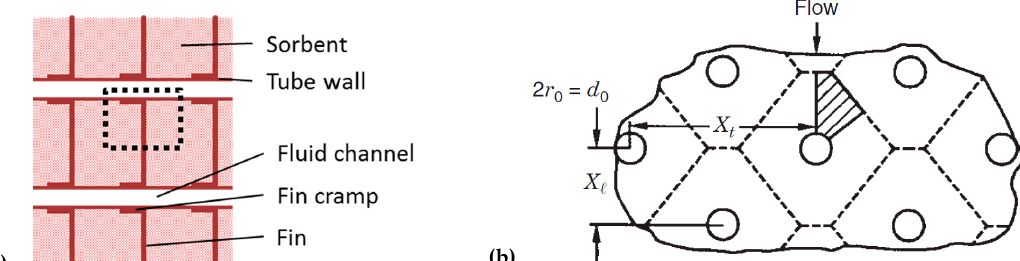
Figure 5. ( a ) A cross-cut along the heat exchanger tubes; the dotted line delimits the section calculated as sorber. ( b ) A plan view of one fin; the shaded area corresponds to the resulting hexagon when dividing fins with the sector method (Source: Shat et al.).